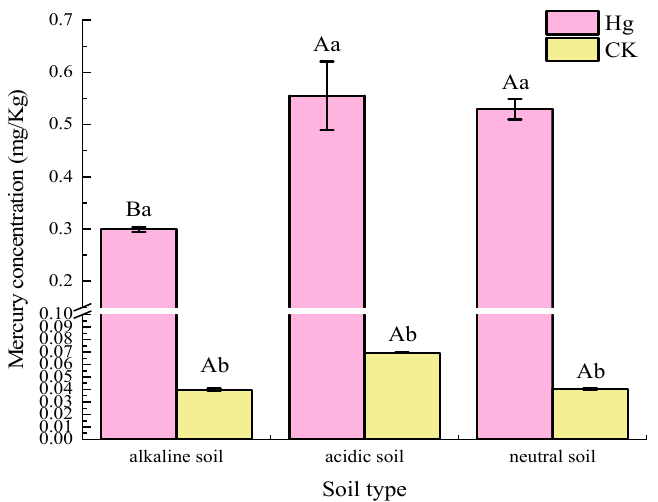
Figure 1. Changes of mercury content in three soils after 180 days of aging. Capital letters in the figure indicate significant differences between soil groups, and lowercase letters indicate significant differences within groups: p < 0.05.